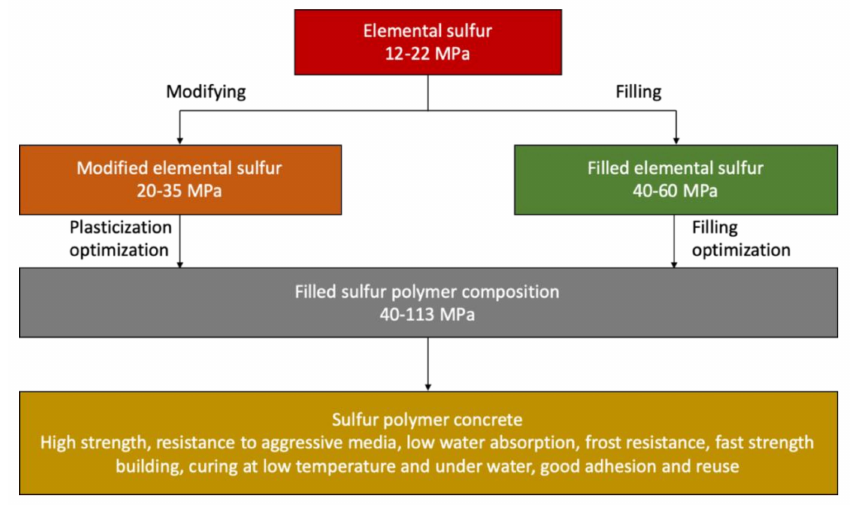
Figure 10. The stages of obtaining sulfur polymer concrete (data extracted from References